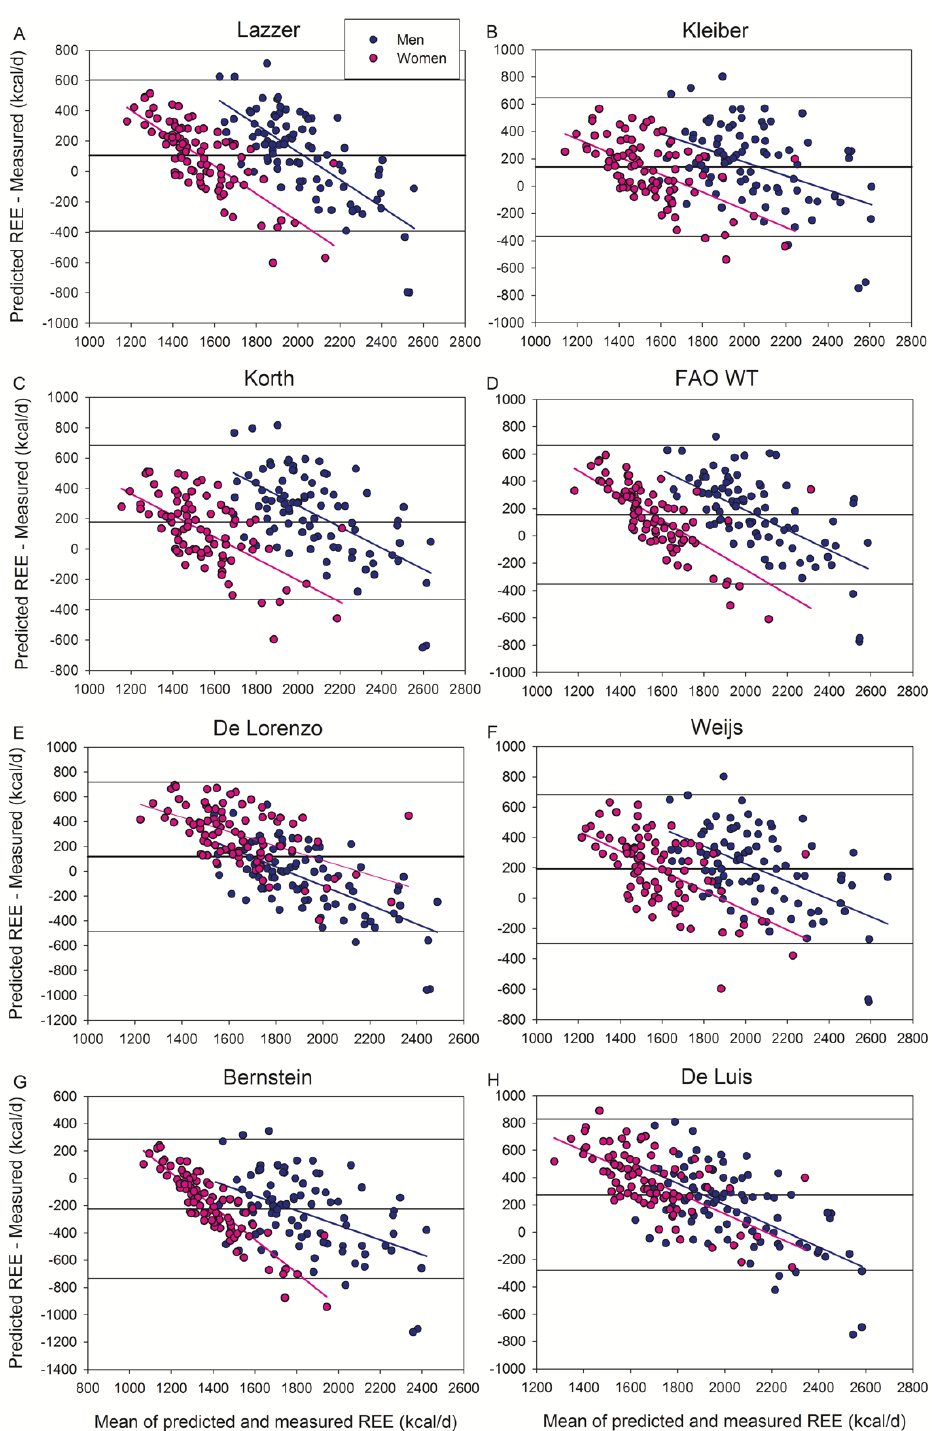
Figure 2. Bland–Altman plots displaying the agreement between measured and predicted REE by the equations of ( A ) Lazzer, ( B ) Kleiber, ( C ) Korth, ( D ) FAO WT, ( E ) De Lorenzo, ( F ) Weijs, ( G ) Bernstein, and ( H ) De Luis. All these equations included obese subjects in their populations. The thick continuous line indicates the mean value of the differences between predicted and measured REE (bias). The thin lines delimit the 95% confidence interval. All the regression lines were statistically significant at p < 0.001, indicating a systematic bias. Note that “Y” and “X” axes have different scales. De Luis equation was obtained using a portable, hand-held device (MedGem) less accurate than metabolic carts.